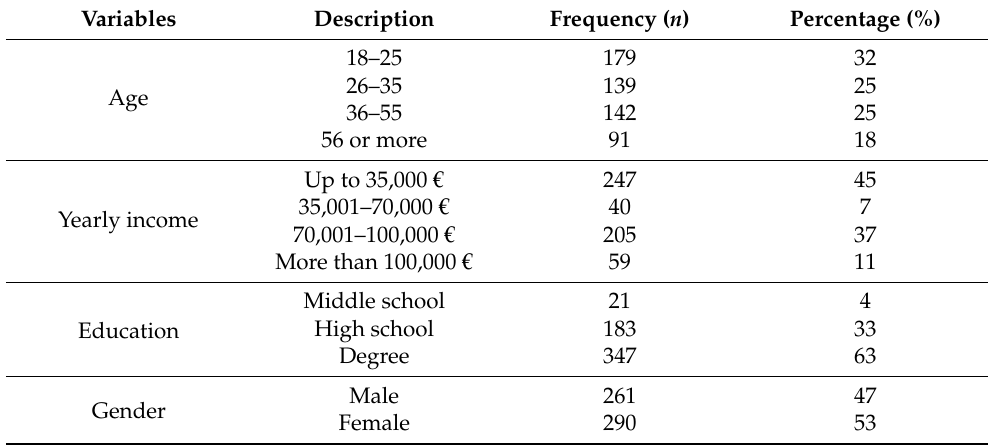
Table 1. Socio-demographic characteristics of the sample, absolute numbers, and relative